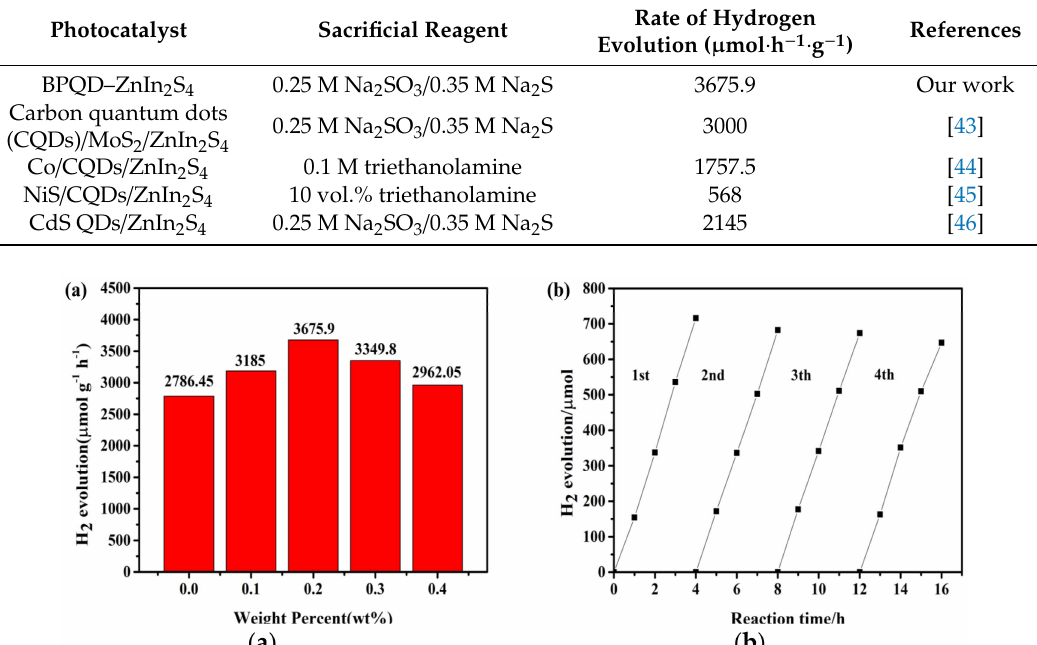
Table 1. Comparation in some photocatalysts.